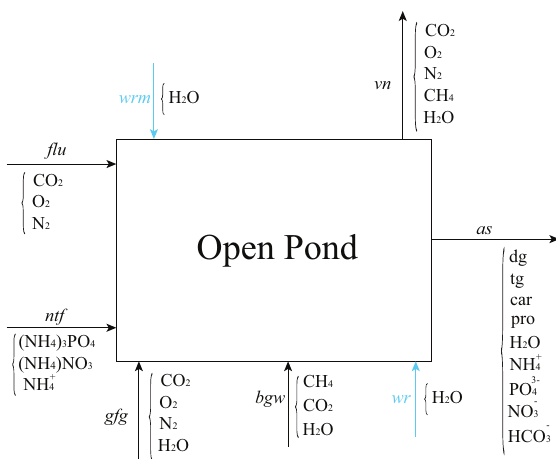
Figure 2. Flow streams into and out of the open pond in the cultivation section of Figure 1. Inflows include a flue-gas stream from a carbon capture plan (flu), nutrients (ntf), flue gas from gas turbine (gfg), liquid stream from biogas upgrading (bgw), recycled water from dewatering section (wr), and makeup water (wrm). Outflows include a vent (vn) to account for water evaporation and unreacted gas emission into the atmosphere and algae slurry (as), non-aqueous phase of which contains diglycerides (dg), triglycerides (tg), proteins (pro), carbohydrates